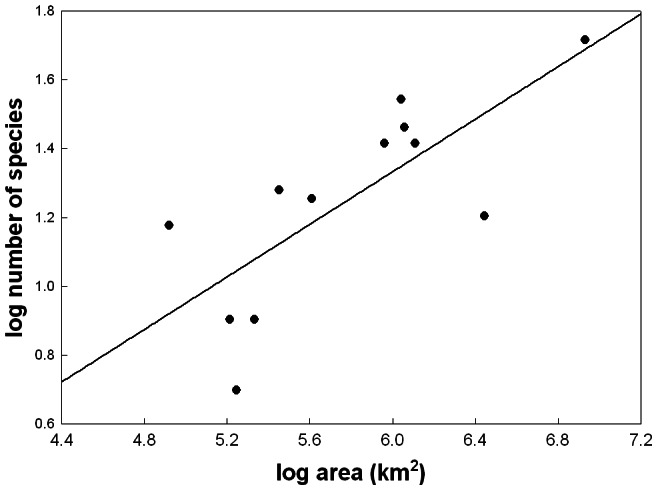
The continental species-area relationship for South American phanaeine dung beetles.Eighty-nine species in 11 genera were included. Each dot corresponds to one of 12 countries (no species have been reported for Chile). See Table S2 for details.